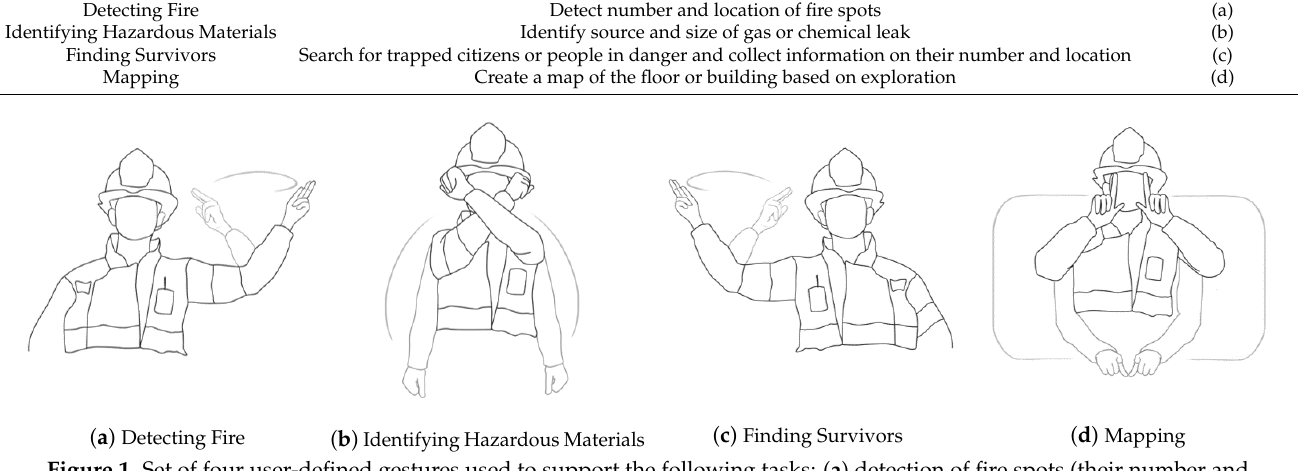
Figure 1. Set of four user-defined gestures used to support the following tasks: ( a ) detection of fire spots (their number and location), ( b ) identification of gas/chemical leak source and size, ( c ) search for trapped citizens or people in danger and collection of information on their number and location, ( d ) mapping of the floor or building. Image courtesy of